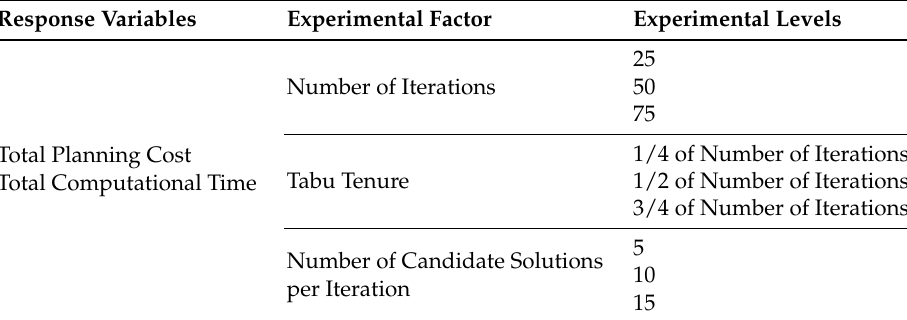
Table 5. Experimental factors and levels.